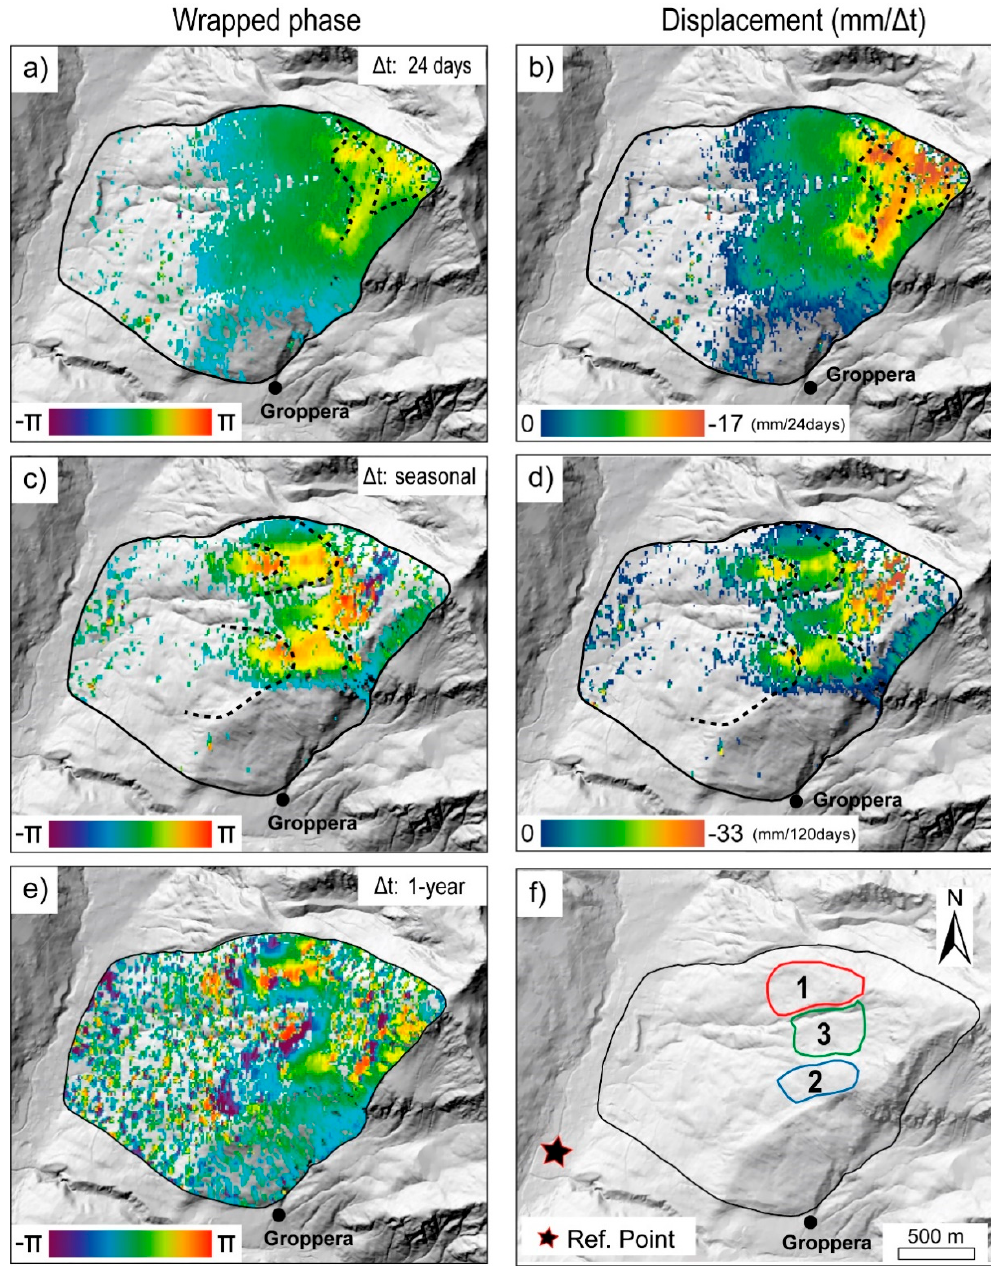
Figure 4. Examples of interferograms and displacement maps obtained by DInSAR with different temporal baselines (images: Sentinel-1 (Track 66, descending). Left column: wrapped phase interferograms with increasing temporal baseline: ( a ) 24 days (2-26 Jul 2017); ( c ) seasonal (June- October 2019); ( e ) 1-year (2018-2019). Right column: ( b ) and ( d ) unwrapped phase converted to displacements (mm). The unwrapped results for the 1-year interferogram were affected by a high noise level and unreliable values, and for reason are omitted; ( f ) sectors 1, 2 and 3, representative of the activity of northern and southern nested landslide heads and the background DSGSD, respectively. 24-days and seasonal wrapped and unwrapped interferograms are masked where the phase coherence of the filtered interferogram is < 0.4 and displacement > 0. On 1-year interferograms pixels with coherence < 0.3 are masked out. The reference point used for phase to displacement conversion is shown.